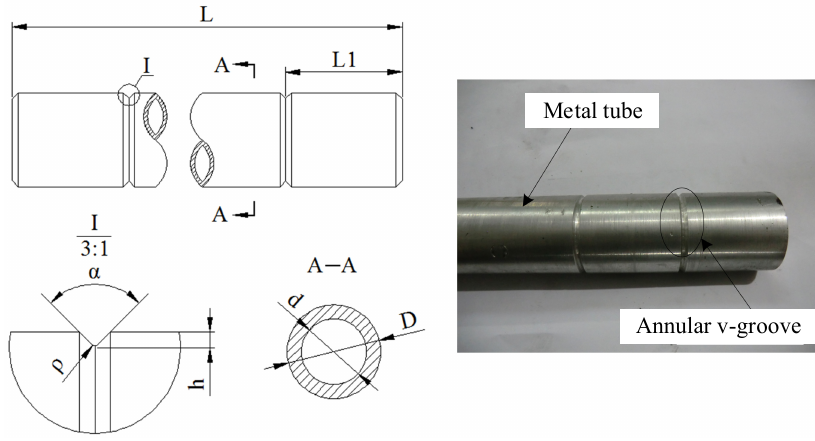
Figure 5. Schematic diagram and physical photos of specimen geometric parameters.